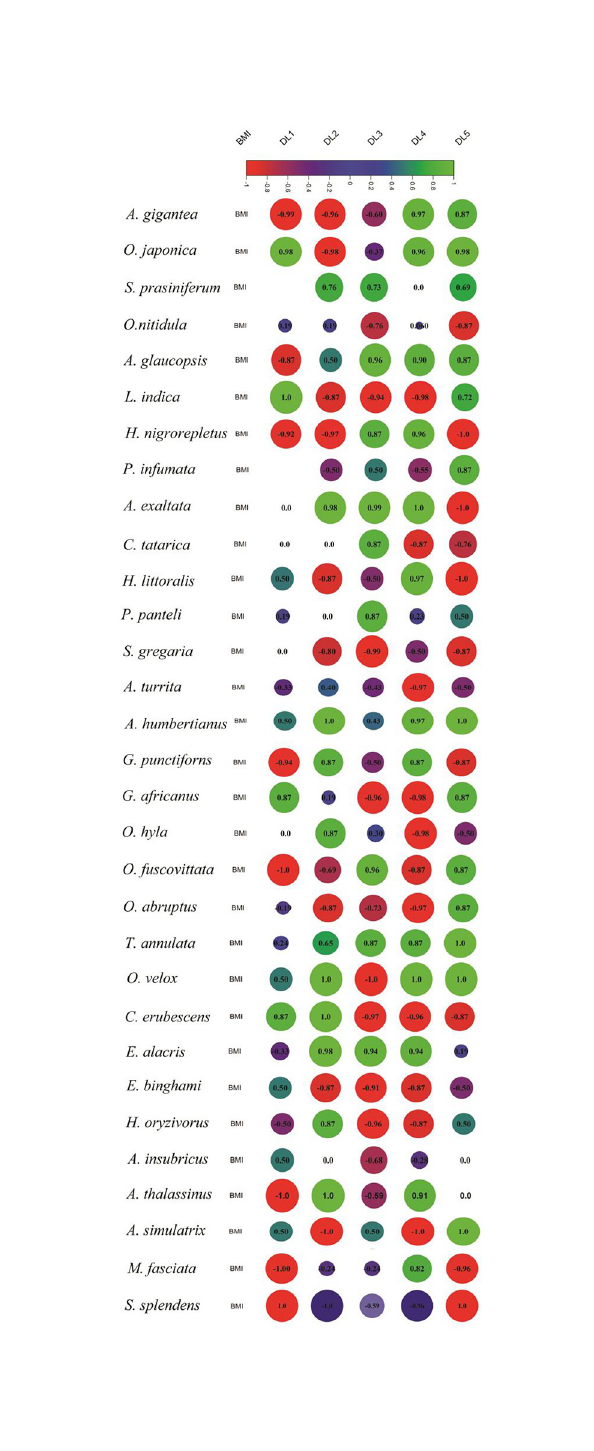
Fig 6. Pearson correlations between body mass index (BMI) of the species (n = 31) and mortality percentage (M %) at different density levels (DL1 to DL5). The species are aligned in ascending order of BMI (from top to bottom) and corresponding M% at each DL. Correlation coefficients ( r ) are represented by circles ranging from -1.0 (red = negatively correlated) to +1.0 (green = positively correlated). The size of the circles corresponds to the value of r (the bigger the circle, the higher the r , and vice versa). Variation of one variable related to the variation of other is